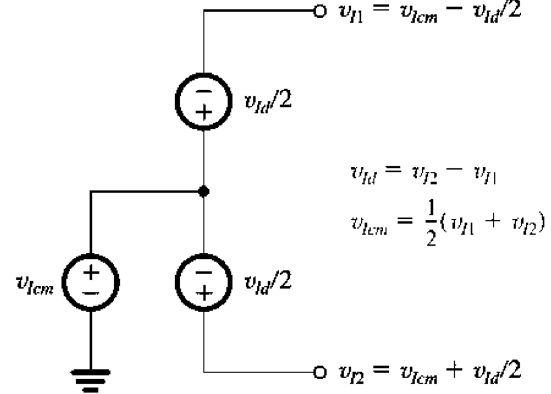
Fig. 8 Differential amplifier showing common-mode components and differential components